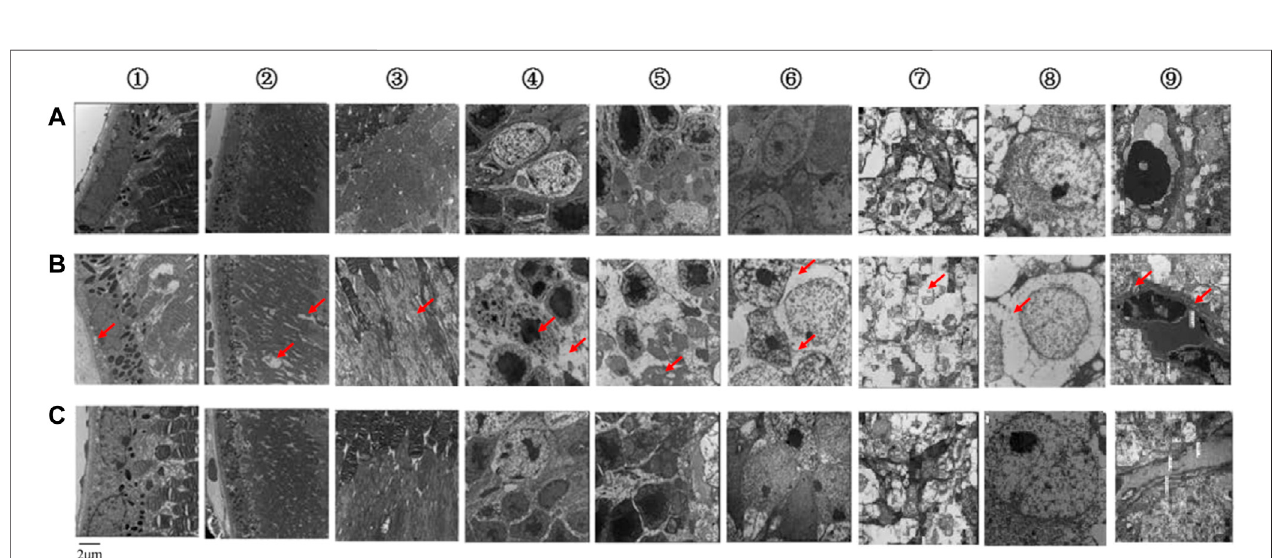
FIGURE 2 | Ultrastructures of each retinal layer and blood vessel as observed by TEM. (A) Control group. (B) Model group. (C) KLX-treated group. KLX alleviated damage to the retinal structure and inhibited thickening of the basement membrane, which prevented progression of DR and reduced damage to visual function. The following are descriptions of results in the KLX-treated group compared with the control and model groups. (A ① – C ① ) RPE cells were arranged regularly, their nuclei wereclearer,and themorphologyofmitochondriainthecytoplasmwasnormal. (A ② – C ② )Inthemembranediscsofvisualcells,structure wasrelativelycomplete, withalmostnofragmentationordissolution,relativelyneatarrangement,andrelativelyclearoutline.(A ③ – C ③ )Inthevisualcelllayer,afewmitochondriashowedswelling andvacuolation.(A ④ – C ④ )IntheONL,thearrangementofconeandrodcellswasmoreregular,andtheextracellularspacewasnarrowed.(A ⑤ – C ⑤ )TheOPLshowed fewer pathological changes of mitochondrial edema and vacuolation. (A ⑥ – C ⑥ ) In the INL, nuclear chromatin of bipolar cells was evenly distributed, the intercellular spacewasnarrowed,thereweremoreorganelles,andthemitochondriawerelessswollen.(A ⑦ – C ⑦ )IntheIPL,thereweremorecompletemitochondria,synapses,and synaptic vesicles. (A ⑧ – C ⑧ ) In the ganglion cells, there were more mitochondria and organelles, less swelling, fewer vacuoles, and clear structure. (A ⑨ – C ⑨ ) In the retinal capillary vessels, the basement membranes of RCECs and pericytes were thinner, and there were fewer vacuolated mitochondria. TEM, transmission electron microscope; KLX, keluoxin; DR, diabetic retinopathy; RPE, retinal pigment epithelial; ONL, outer nuclear layer; OPL, outer plexiform layer; INL, inner nuclear layer; IPL, inner plexiform layer; RCECs, retinal capillary endothelial cells.